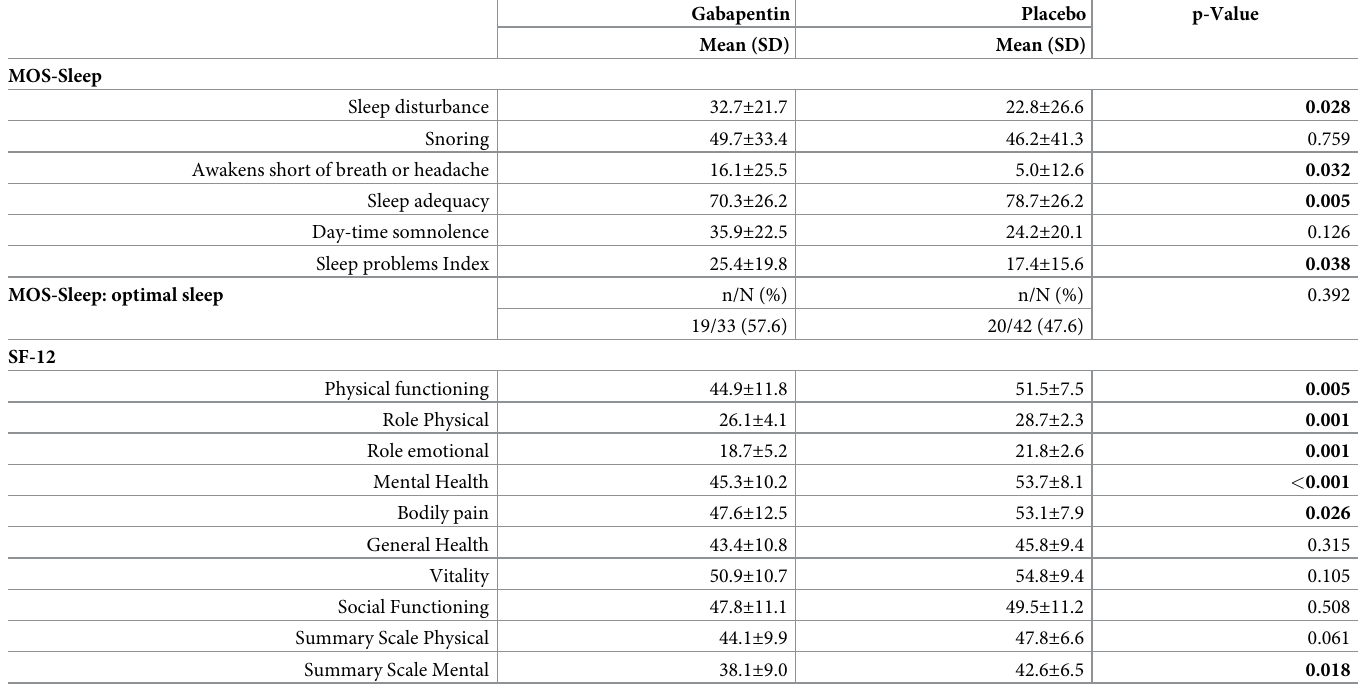
Table 4. Sleep problems and quality of life at week -12 in the two groups.